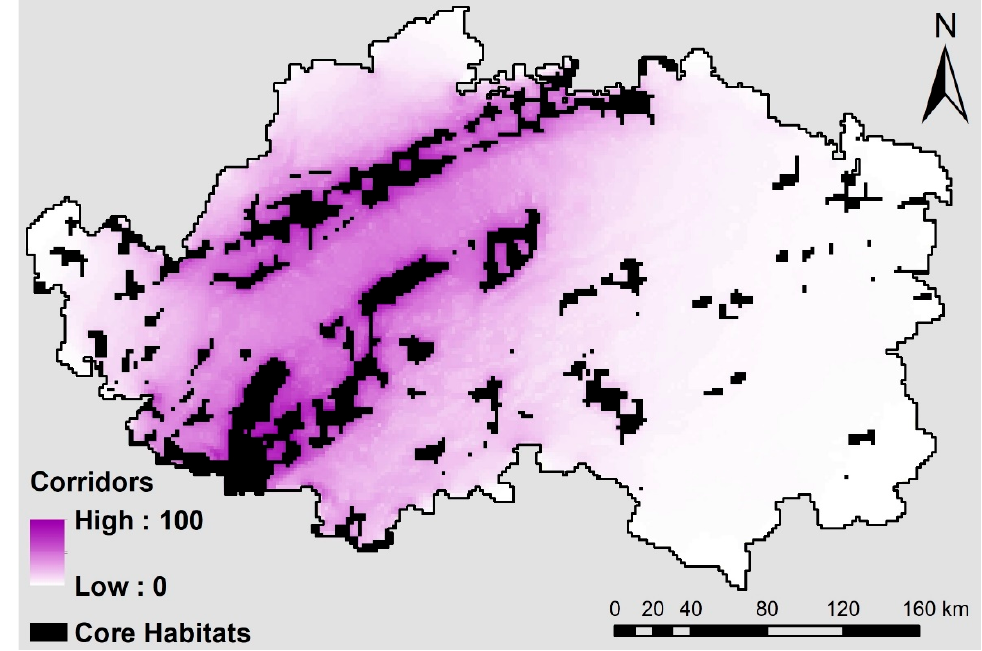
Figure 8. Integrated antelope conservation area created by combining the core habitats and corridors of all four focal species.